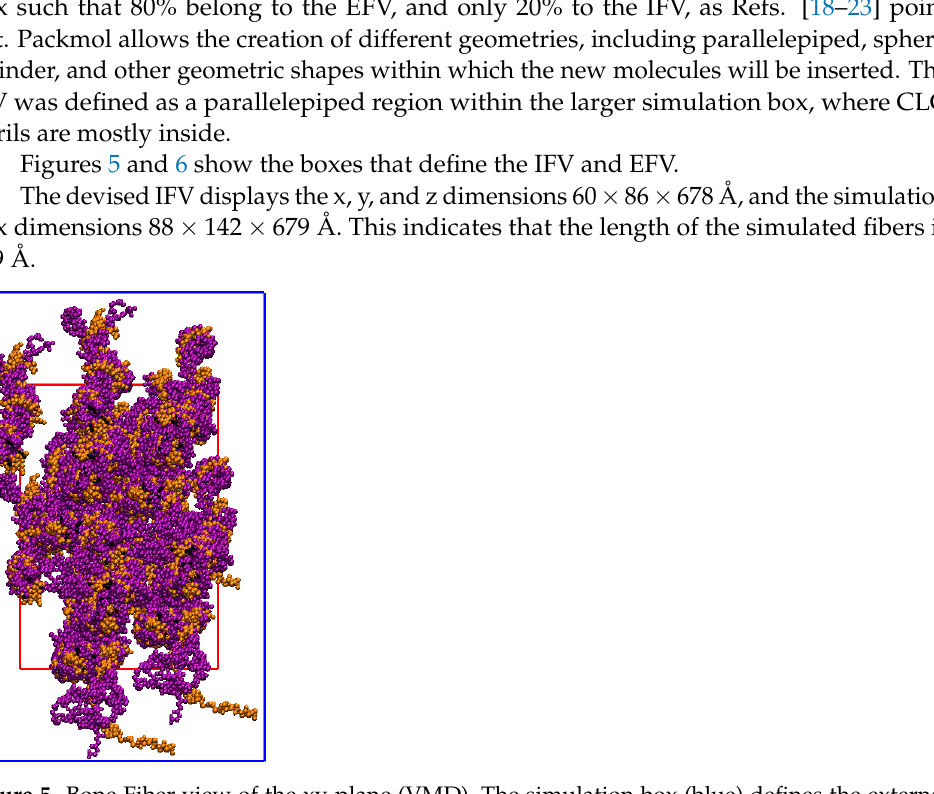
Figure 5. Bone Fiber view of the xy-plane (VMD). The simulation box (blue) defines the external boundary of the EFV. The IFV box (red) defines the external boundary of the IFV and the internal boundary of the EFV. Only CLG backbone molecules are